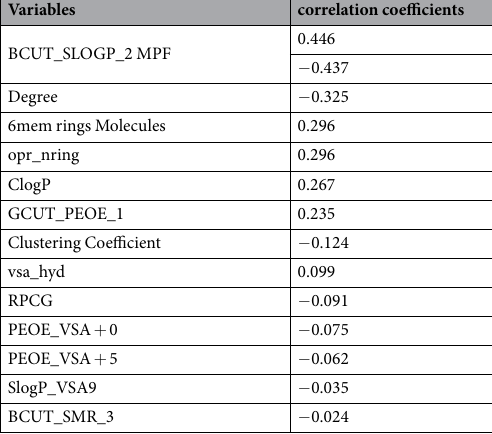
Table 3. Correlation coefficients between selected variables and − logC.